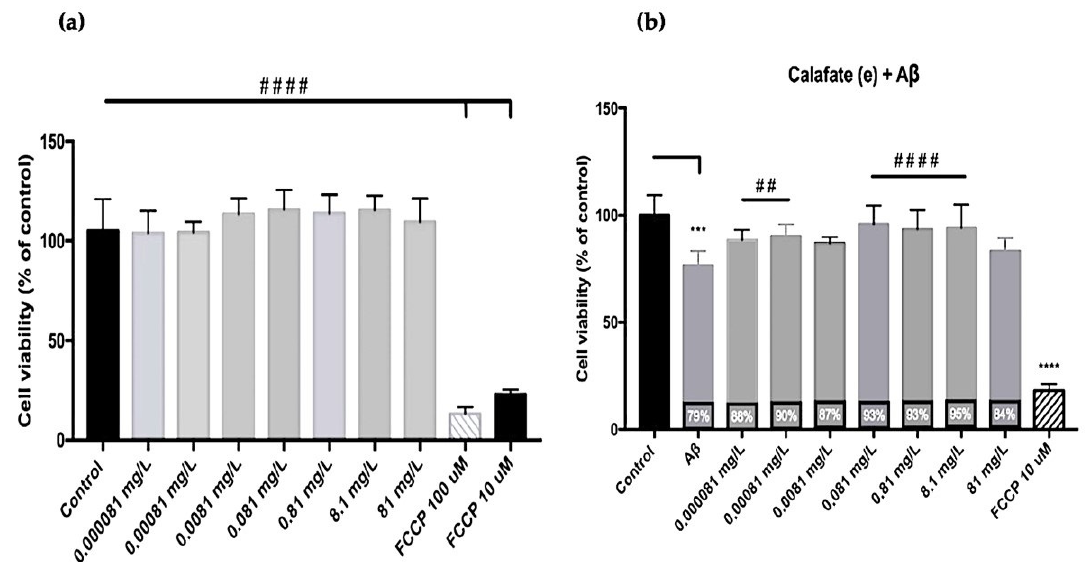
Figure 5. Effect of calafate powders on PC12 cell viability. ( a ) Comparative graphs of cell viability with increasing concentrations of the powder; ( b ) effect of encapsulated calafate on the reduction of cell viability induced by amyloid β -peptide oligomers (0.5 uM). Acetylcholinesterase activity (AChE) of powdered calafate, obtained by spray drying. FCCP: carbonyl cyanide4-(trifluoromethoxy)phenylhydrazone; A β : Amiloid beta. Statistical significance is found as *** ( p < 0.01), ## ( p < 0.05) and ****/#### ( p < 0.001).